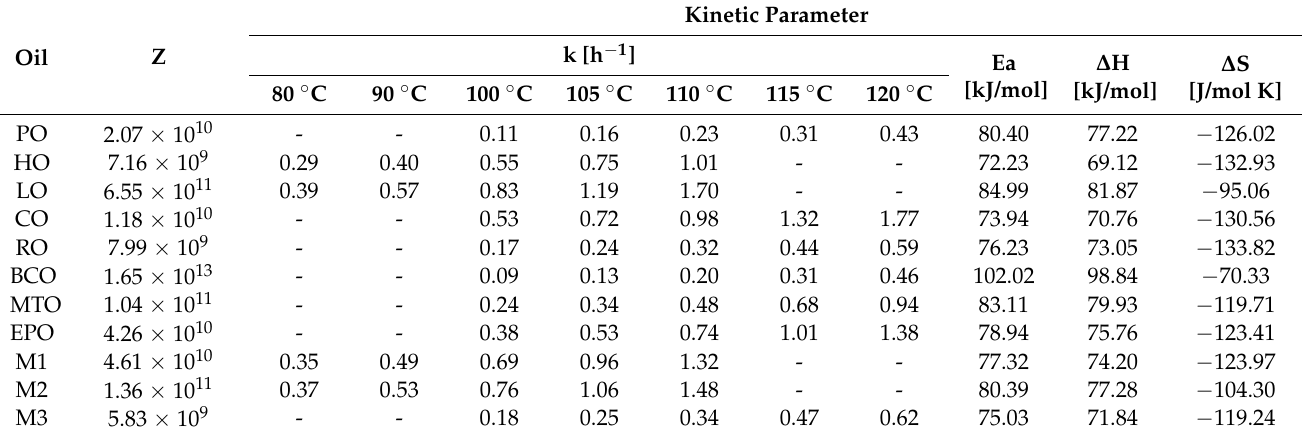
Table 5. Oxidation kinetics parameters of analysed